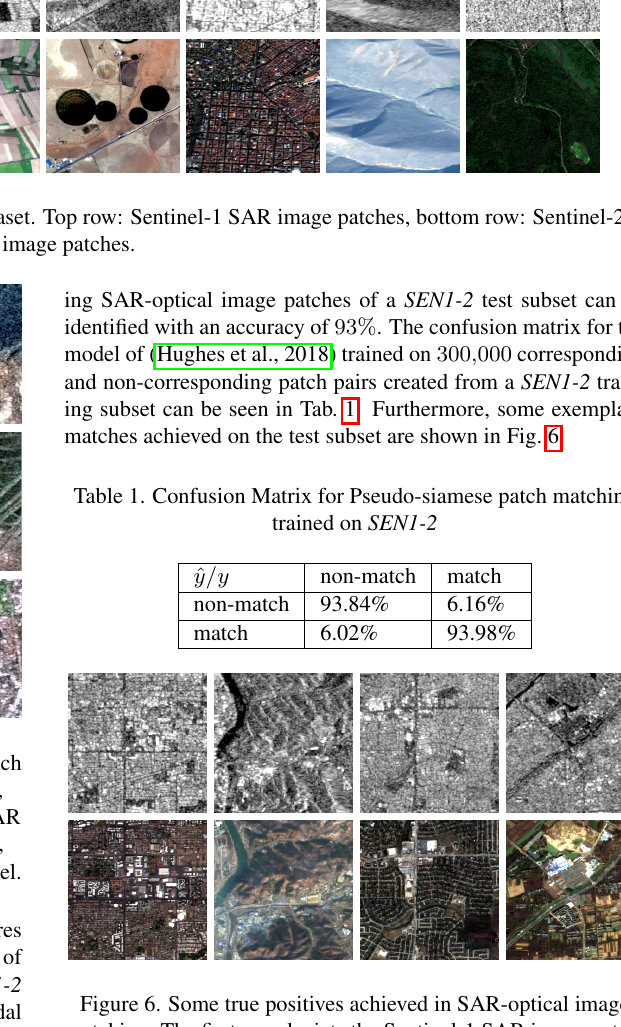
Figure 6. Some true positives achieved in SAR-optical image matching. The first row depicts the Sentinel-1 SAR image patch, while the second row depicts the corresponding Sentinel-2 optical patch as predicted by a pseudo-siamese convolutional neural